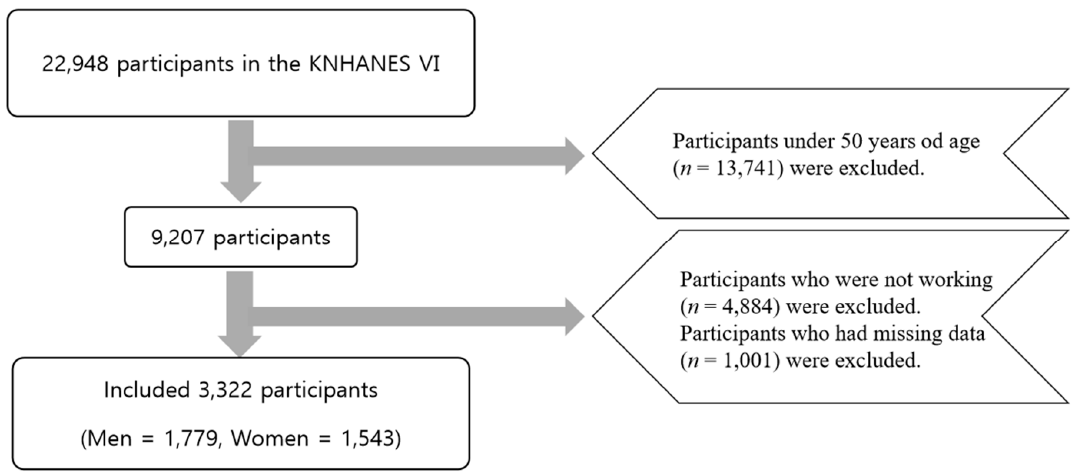
Figure 1. Diagram showing the flow of participants through the study. KNHANES, Korea National Health and Nutrition Examination Survey.